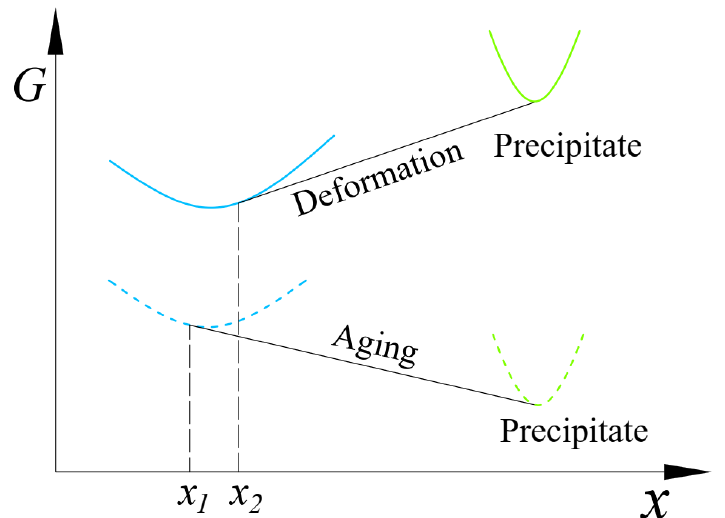
Figure 7. Schematic illustration of Gibbs free energy changes for the α -Al matrix and precipitate under different conditions. Blue lines represent α -Al matrix and green lines represent precipitate; G represents Gibbs free energy and x represent the concentration of solute atoms.